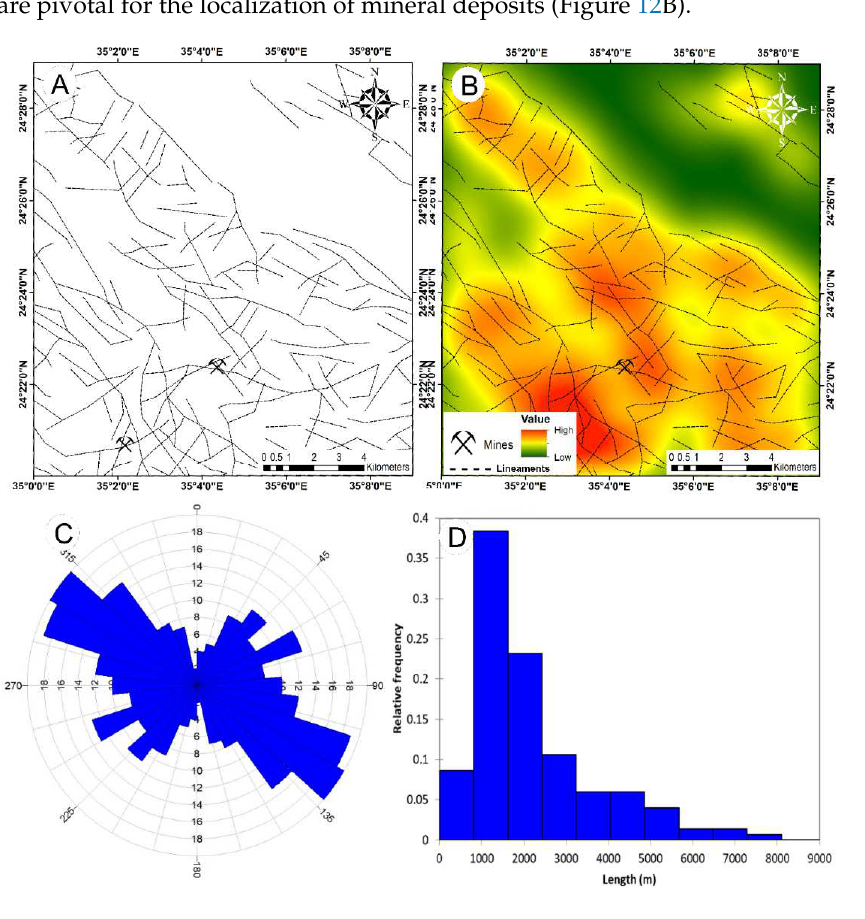
Figure 12. ( A ) Lineament distribution across the study location. ( B ) Lineament density analysis for the study location. ( C ) Rose diagram plot for lineaments. ( D ) Histogram plot for lineament length.